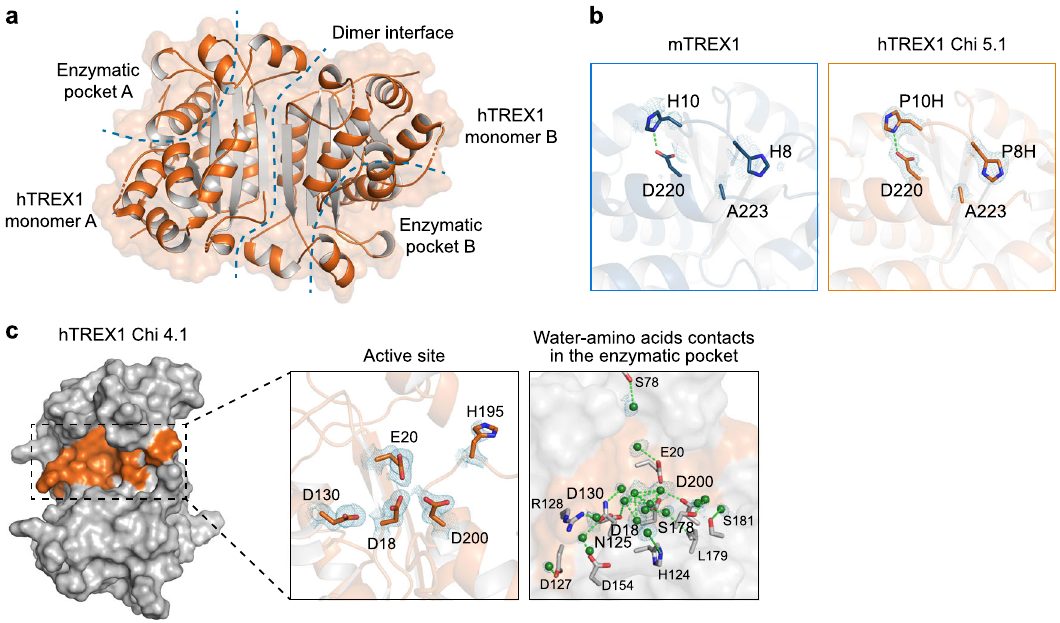
may stabilize protein package and facilitate crystal formation. c Overview of a single hTREX1-unit in the hTREX1 dimer zoom-in cutaways of the TREX1 enzy- matic pockets. The contacts of waters and amino acids in the core of enzymatic pocket is shown to the right as zoom-in cutaway. Green dots denote water molecules. 2Fo – Fc electron density map of water is highlighted (contoured at 1.0 σ ). See also Supplementary Fig. 3. Supplementary Fig. 4b. c Overview of a single 1:1 TREX1-unit in the hTREX1 – DNA complex with zoom-in cutaways showing TREX1 to the 5 ′ and 3 ′ DNA contacts. The human-speci fi c 5 ′ contacts by K160 and R164 are highlighted. See also Supple- mentary Fig. 4.